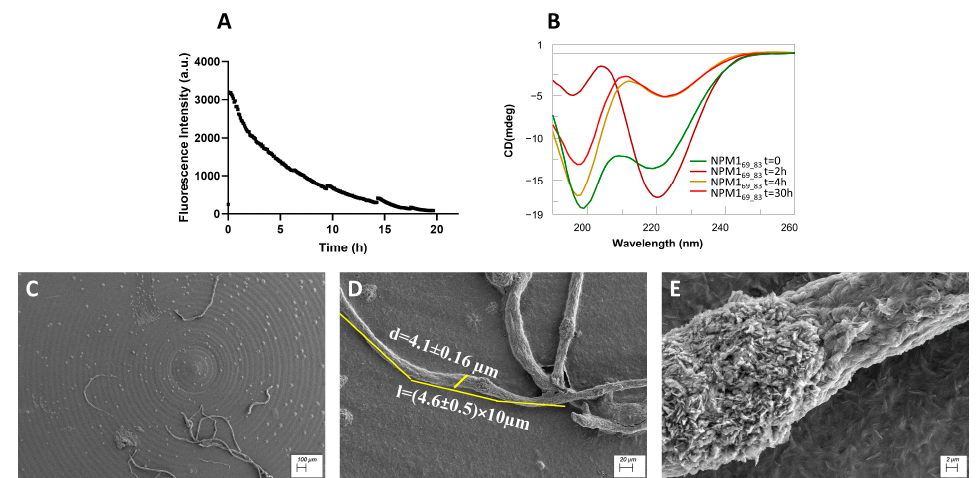
Figure 2. NPM1 41–65 characterization: ( A ) Time course of ThT fluorescence emission intensity; ( B ) CD spectra over time; ( C – E ) SEM micrographs registered at 24 h at 100, 20 and 2 µm.